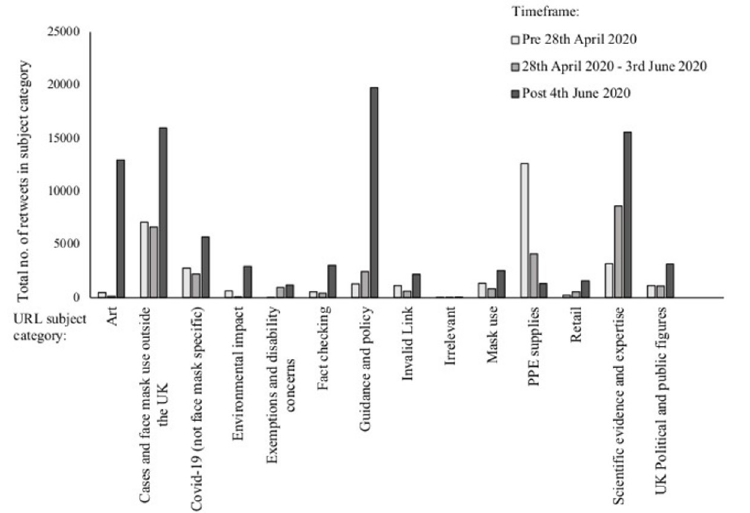
cussed as much in comparison.